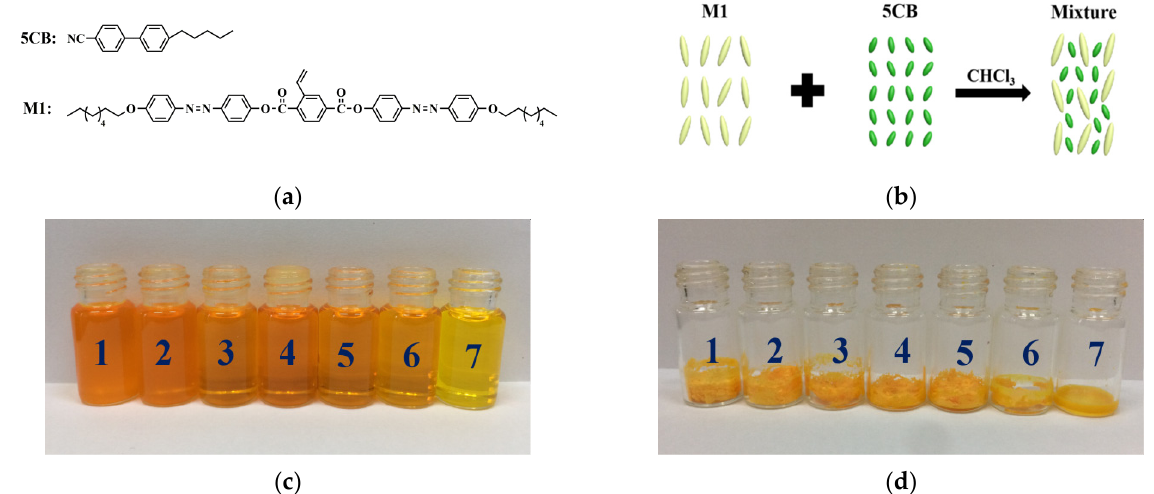
Figure 3. ( a ) Chemical structure of 5CB and M1. ( b ) Fabrication process of the M1 and 5CB liquid crystal (LC) mixtures. ( c ) In CHCl 3 solution and ( d ) evaporated solvent photographs of LC mixture samples (1–7) with different mass fractions of M1 and 5CB. The mass fractions of 5CB in samples (1–7) are 20 wt%, 40 wt%, 60 wt%, 80 wt%, 90 wt%, 95 wt%, and 97.5 wt%,